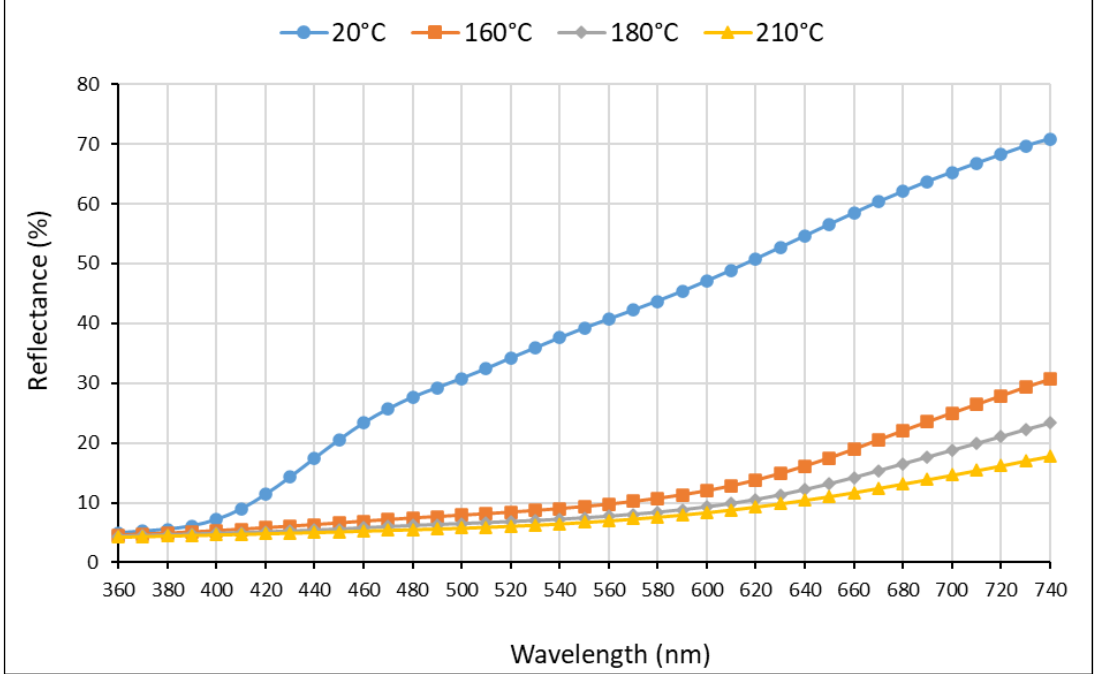
Figure 3. VIS reflectance spectra of untreated and heat-treated black locust wood.